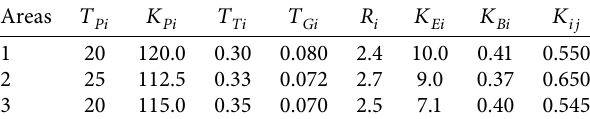
Table 1: The parameters of three-area power system.